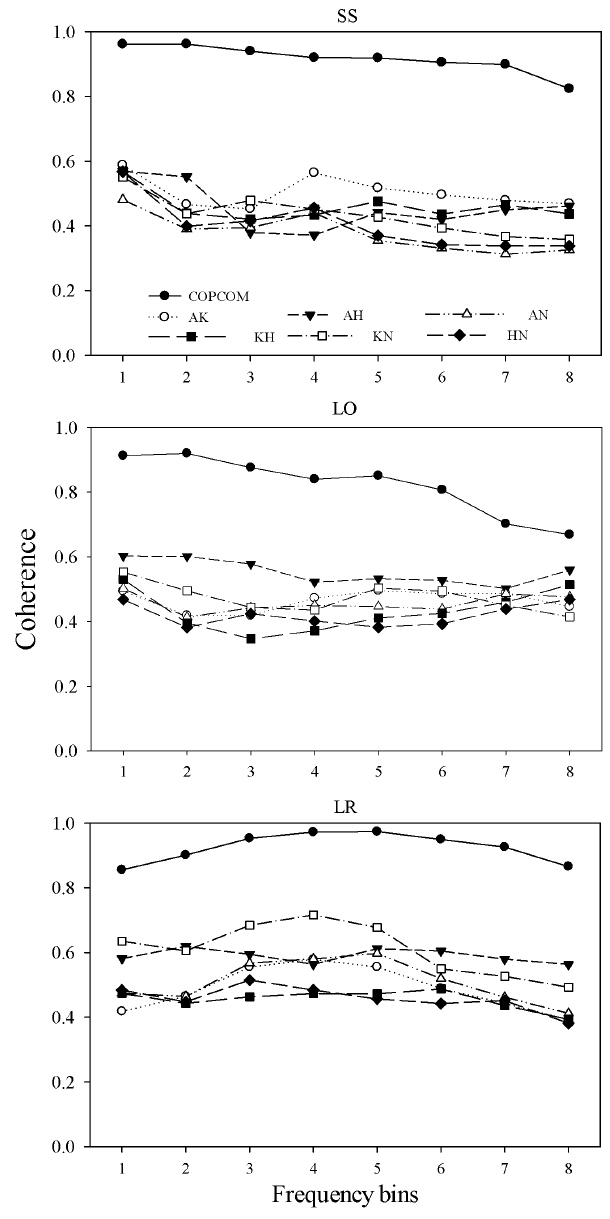
Figure 2. Coherence (group mean) of all pairs of joint angle position (AK: ankle-knee, AH: ankle-hip, AN: ankle-neck, KH: knee-hip, KN: knee-neck, HN: hip-neck) and COP-COM cou- pling at different standing conditions (SS: side-by-side, LO: single left-foot standing, LR: single-left foot standing with body rocking at the ankle joint). Frequency bins are: 1) 0.0167– 0.1002 Hz; 2) 0.1169–0.2004 Hz; 3) 0.2171–0.3006 Hz; 4) 0.3173– 0.4008 Hz; 5) 0.4175–0.5010 Hz; 6) 0.5177–0.6012 Hz; 7) 0.6179– 0.7014 Hz; and 8) 0.7181–0.8016 Hz. Fig. 4 illustrates the cophase of all pairs of comparison in both the collective and component levels. The COP-COM cophase patterns were essentially identical for these three postural tasks, in which the COP and COM moved in the same direction instantaneously (cophase , 0 u ) from 0.0167 to 0.1169 Hz and gradually decreased at the relatively high frequencies. The negative COP-COM cophase relation indicates that the COM